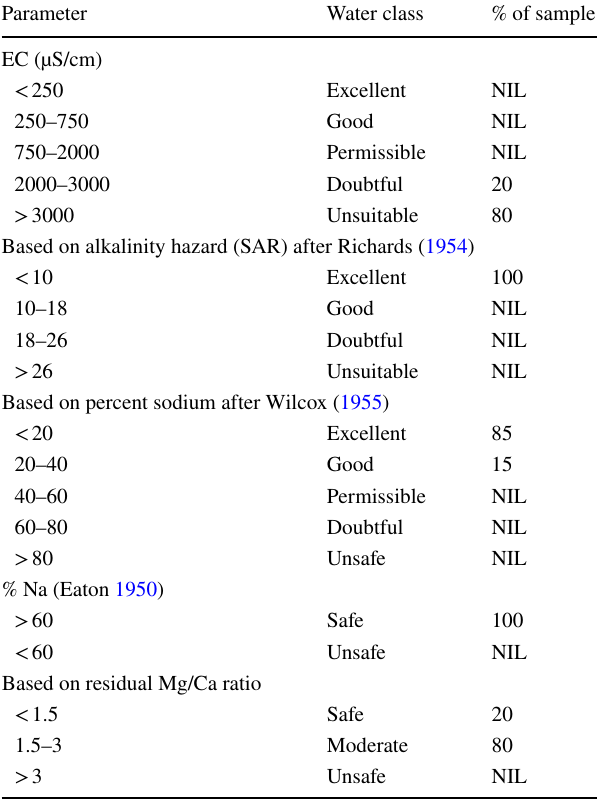
Table 6 Suitability of groundwater for irrigation based on several